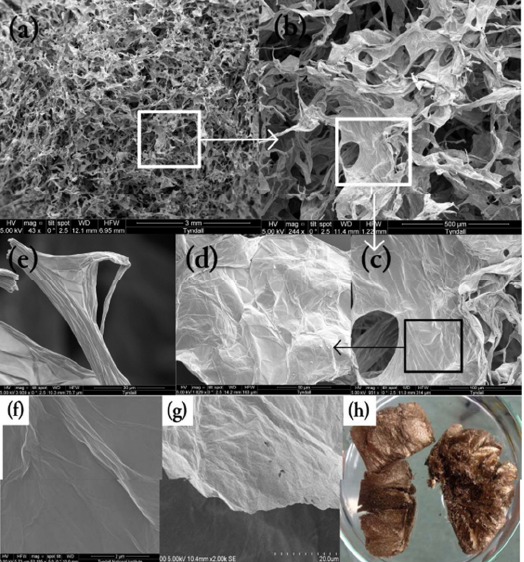
Table A2. Example of [acid]/[base] ratio for Diclofenac at various pH values.